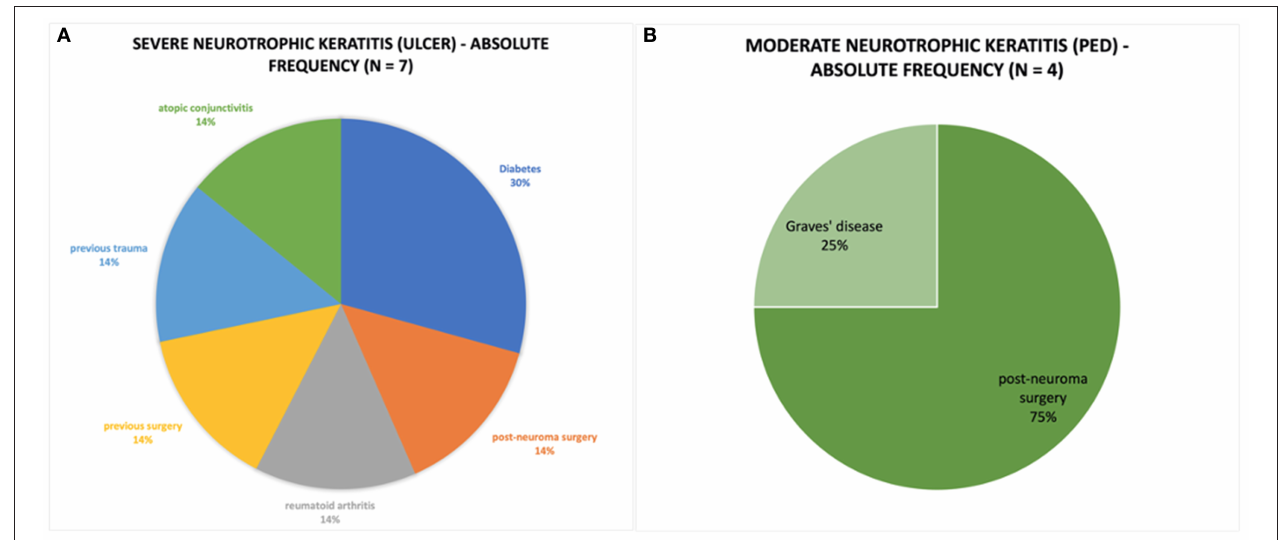
FIGURE 1 | (A) Pie chart represent the absolute frequency of cases of severe neurotrophic keratitis caused by systemic pathology. (B) Pie chart representing the absolute frequency of cases of moderate neurotrophic keratitis caused by systemic pathology.